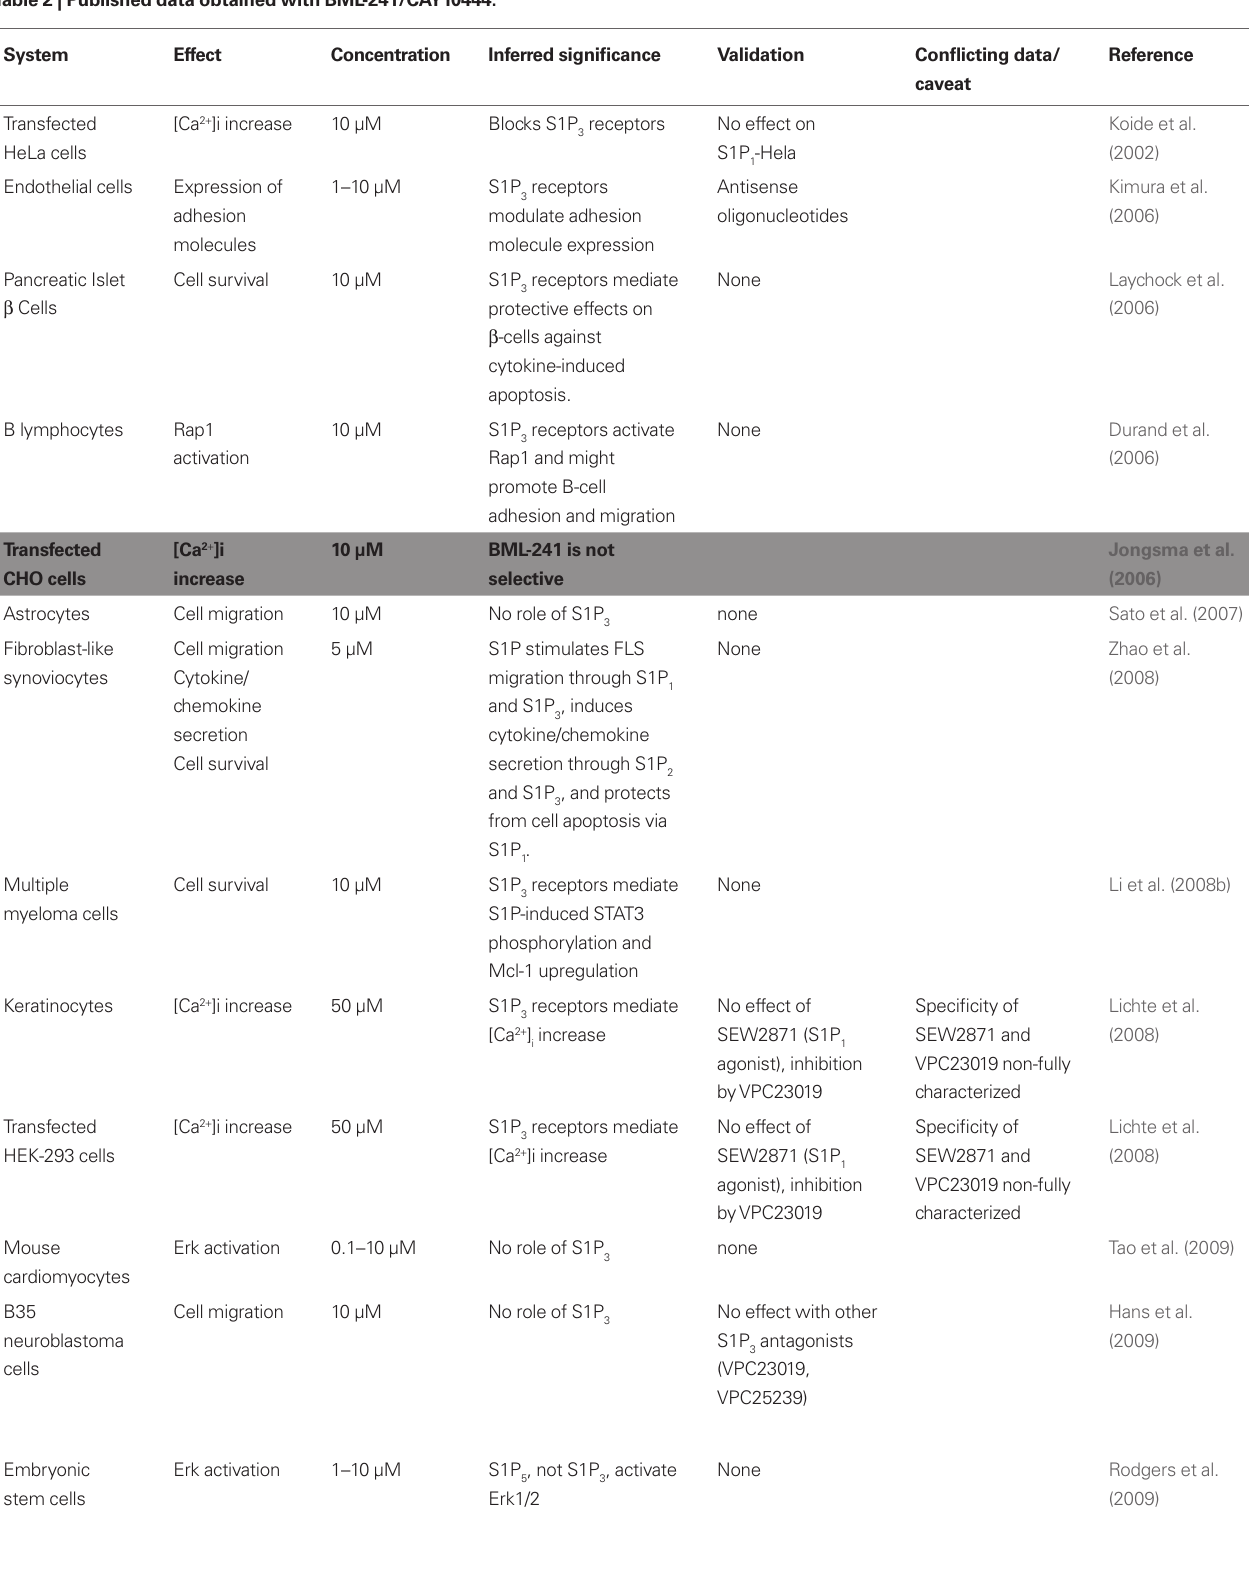
Table 2 | Published data obtained with